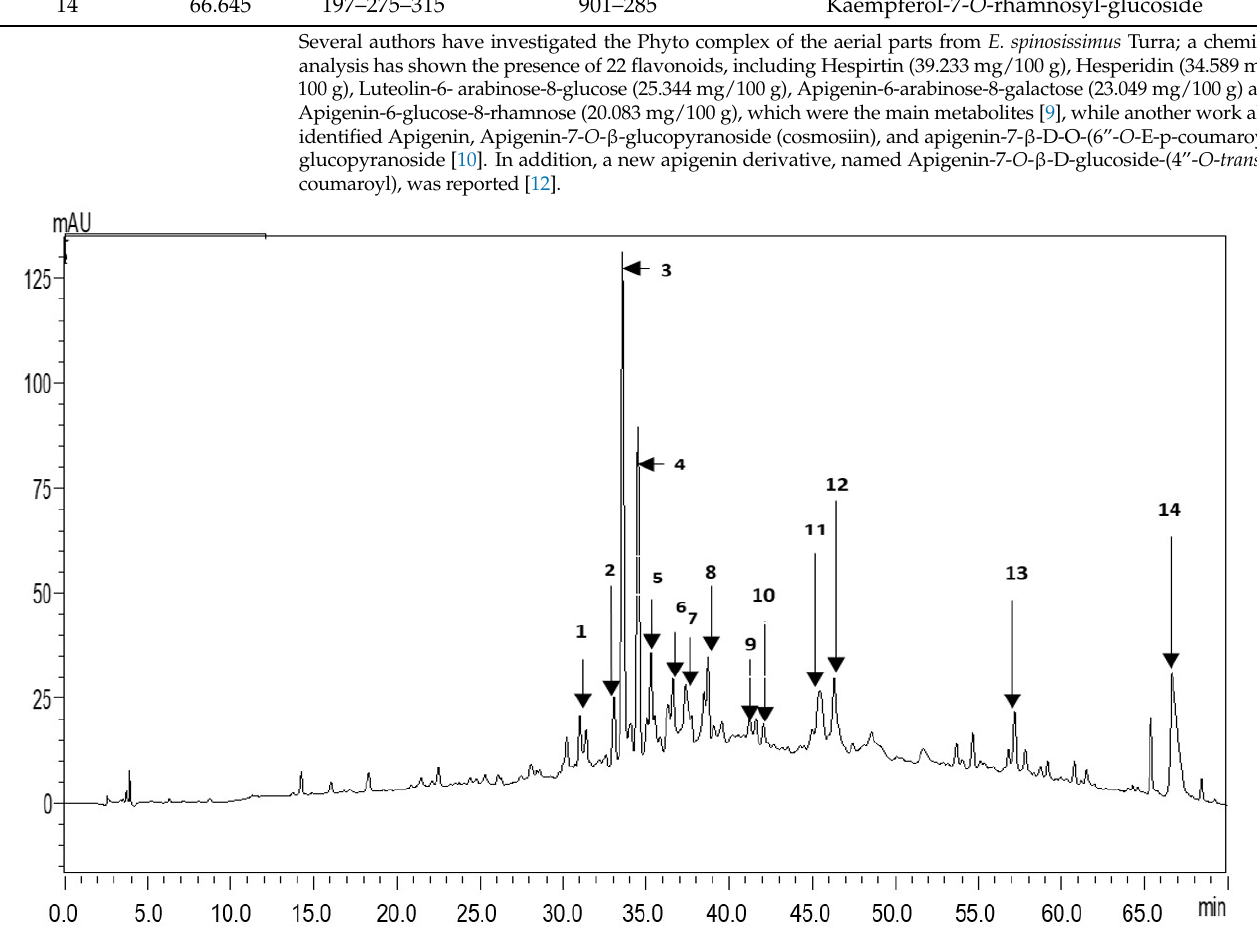
Figure 1 . UV chromatogram of E. spinosissimus root methanol extract at 280 nm. Figure 1. UV chromatogram of E. spinosissimus root methanol extract at 280